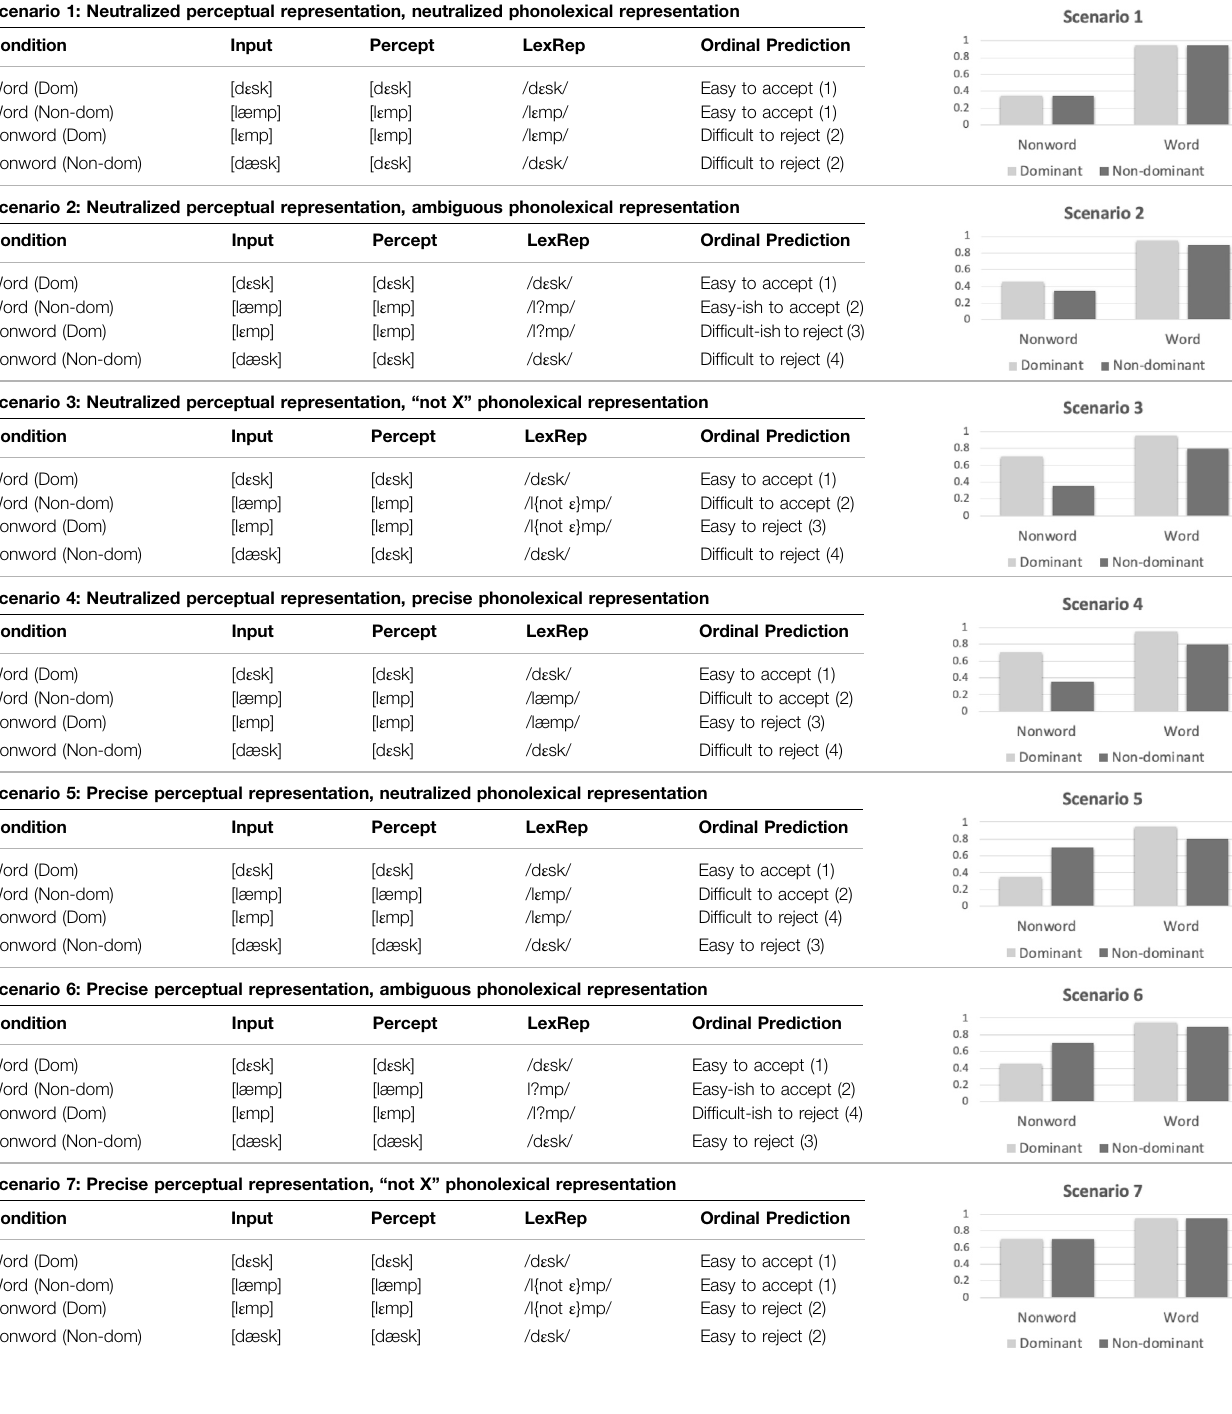
TABLE 2 | Lexical Decision Scenarios and Ordinal Accuracy Predictions. Summary of the eight scenarios created by crossing neutralized and precise perceptual representations with neutralized, ambiguous, “ not X, ” and precise phonolexical representations. Each condition (Dom (cid:1) Dominant; Non-dom (cid:1) Non-dominant) is followed by the corresponding input, percept, phonolexical representation (LexRep) and ordinal accuracy prediction; 1 (cid:1) highest/high accuracy, 4 (cid:1) lowest/low accuracy. Each scenario is accompanied by a stylized fi gure illustrating the ordinal accuracy predictions (note that accuracy predictions are relative, not absolute). Relative